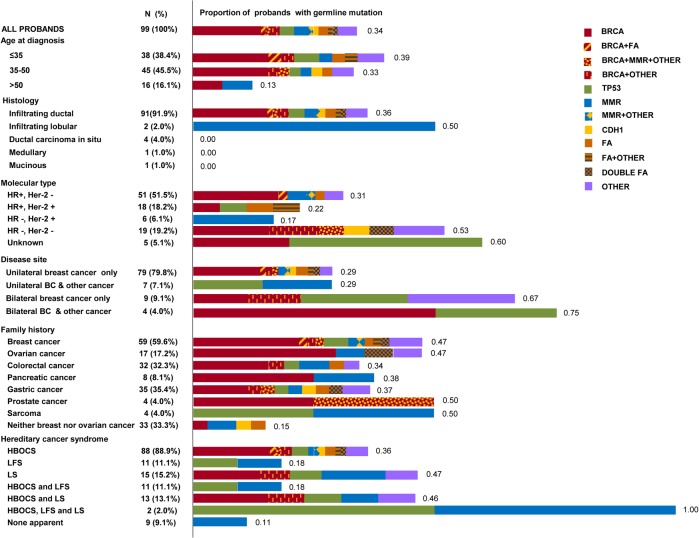
Characteristics of 99 probands and their families, and proportions of probands with germline deleterious mutations.This figure consisted of two aspects. The left column presented the overview of characteristics of the 99 probands and their families. It provided the numbers and proportions of each subgroup. The right color lumps reflected the proportions of probands with different gene mutations in each subgroup. The numbers on the right side of the color lumps represented the proportions. Proportions of probands with one gene mutation are shown in pure color squares, and proportions of probands with mutations in two or more genes are shown in two-color squares. Abbreviations and definitions are as follows: HR, hormone receptor; Her-2, human epidermal growth factor receptor 2; BC, breast cancer; HBOCS, hereditary breast and ovarian cancer syndrome; LFS, Li-Fraumeni syndrome; LS, Lynch syndrome; FA, Fanconi anemia genes, including RAD50, PALB2, FANCD2, FANCI, SLX4, and RAD51C. MMR, mismatch repair genes, including MLH1, MLH3, and MSH3. OTHER, other genes, including RGSL1, CDKN2A, SPINK1, TNFRSF13B, FGFR3, WRN, MUTYH, and CYP17A1.